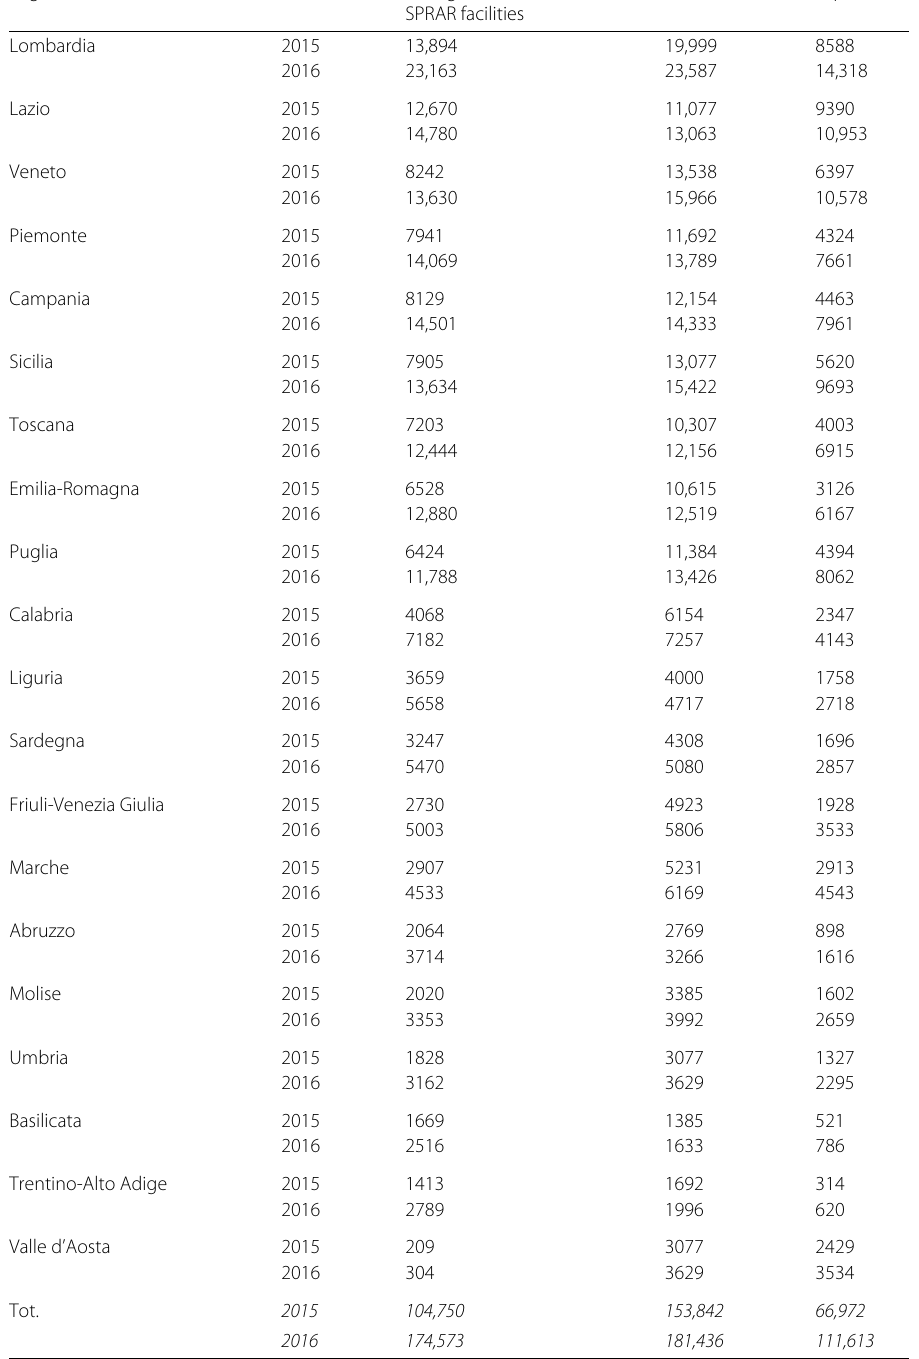
Table 1 Immigration trends 2015–2016 in Italy (Regional level)